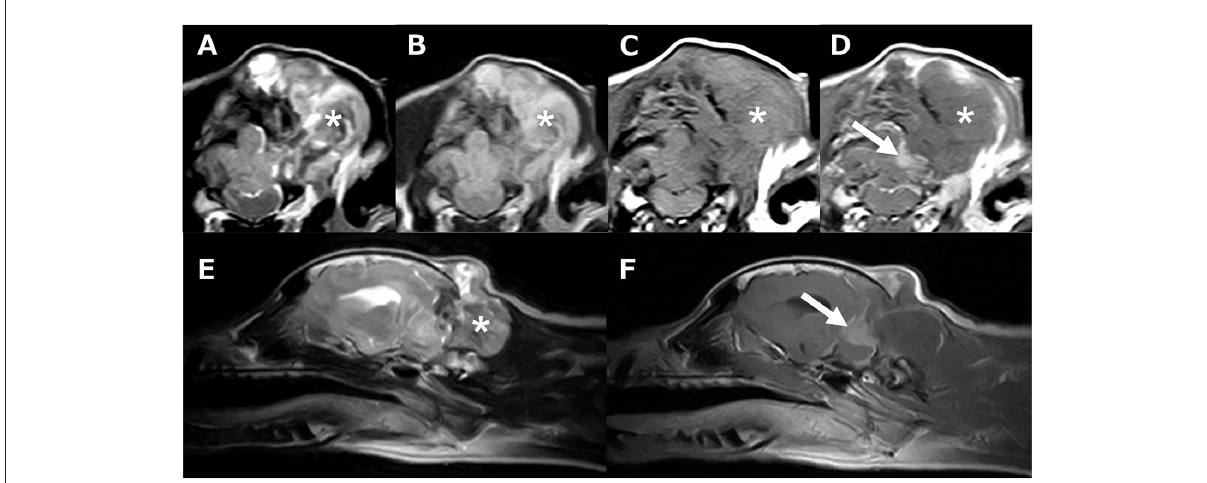
FIGURE2 Head MR images. Transverse T2 weighted (A) , FLAIR (B) , T1 weighted (C) , and T1 weighted post-contrast (D) images at the level of posterior fossa, and sagittal T2 weighted (E) and T1 weighted post-contrast (F) at the level of the left cerebellum. A large mass lesion was found in the left occipital subcutaneous tissue, posterior fossa, and left cerebellar bridge angle region. The mass showed mixed hyper intensity was recognized extracranial region (*) and strong enhancement on the margins and near the meninges (arrow).